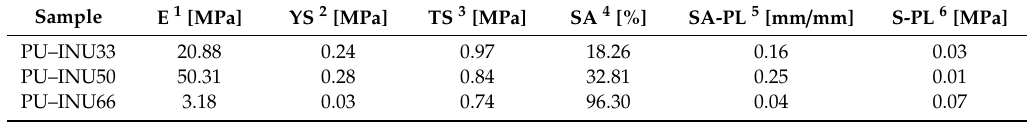
Table 3. Mechanical properties values obtained of the synthesized PU–INU.